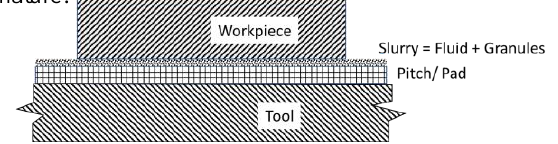
Fig. 2. Layout of NC polishing machine with horizontal